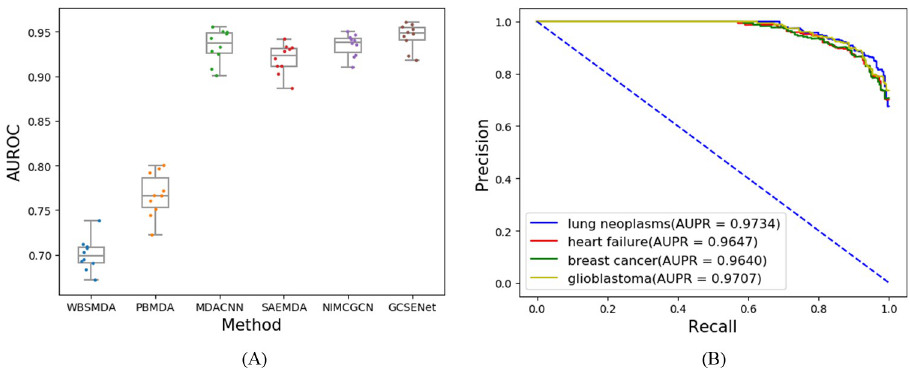
Fig 8. AUROC of miRNA-phenotype in 10-fold cross-validation (A), and Precision-Recall curve of lung neoplasms, heart failure, breast cancer and glioblastoma